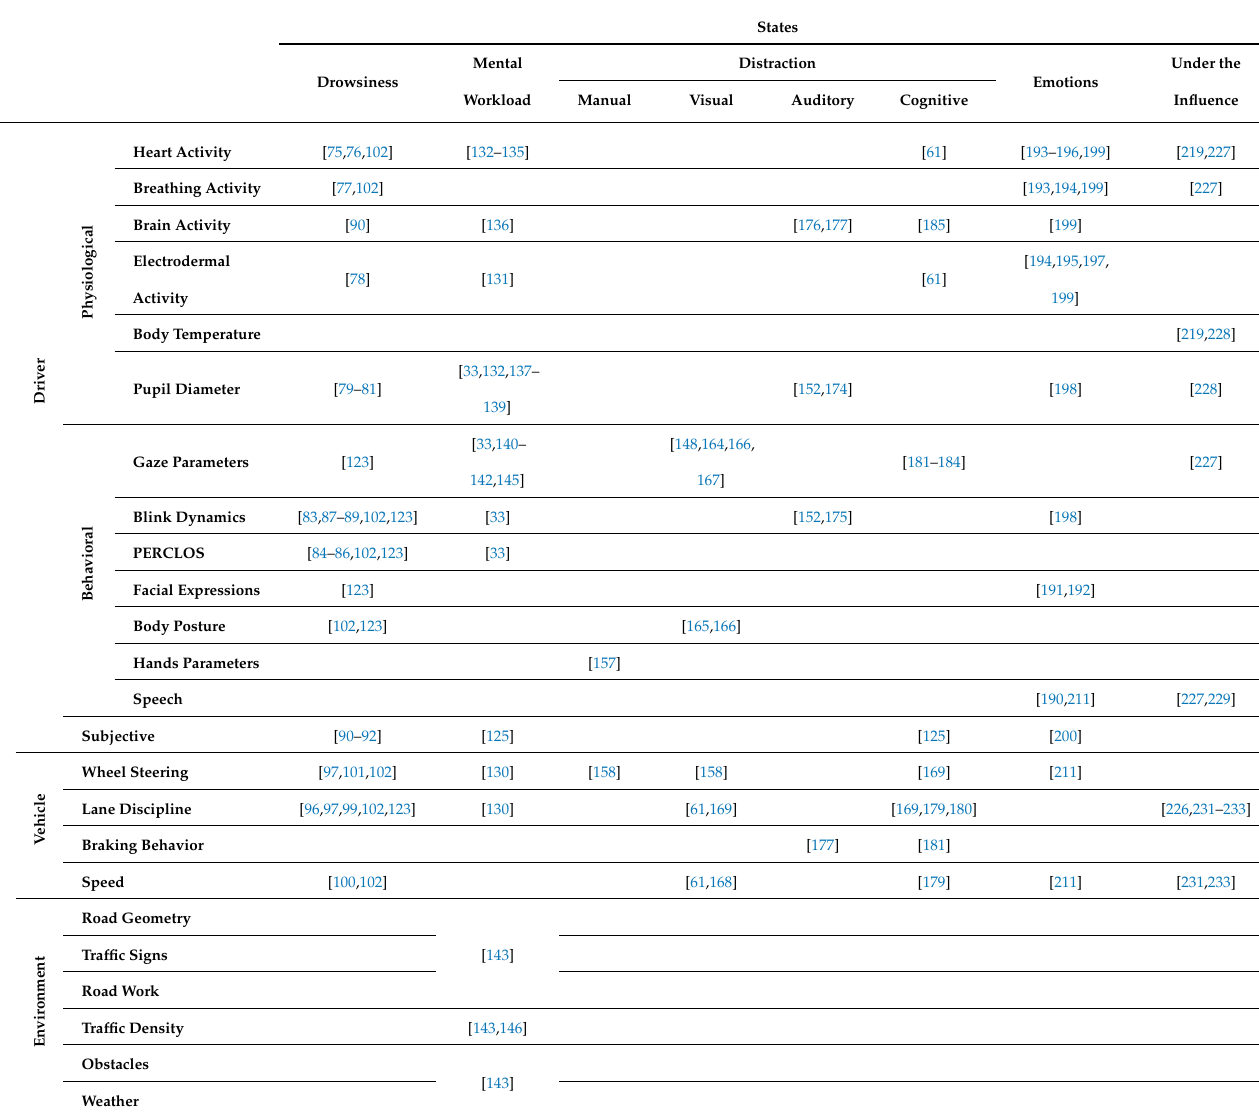
Table 4. Detailed “states vs. indicators” table, introduced in simplified form in Figure 3. Each cell in the heart of the table gives some references (if any) discussing how the corresponding indicator is useful for characterizing the corresponding